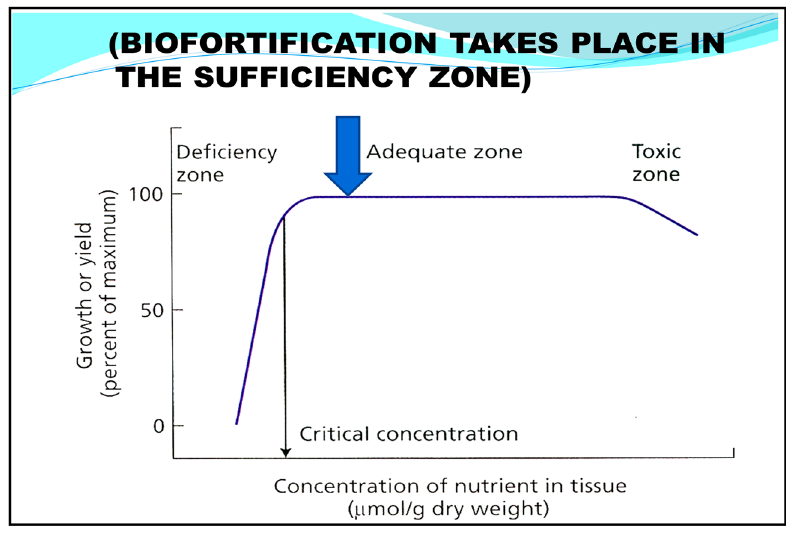
Figure 3: Fertilizer dose – response curve for bioforti fi cation of